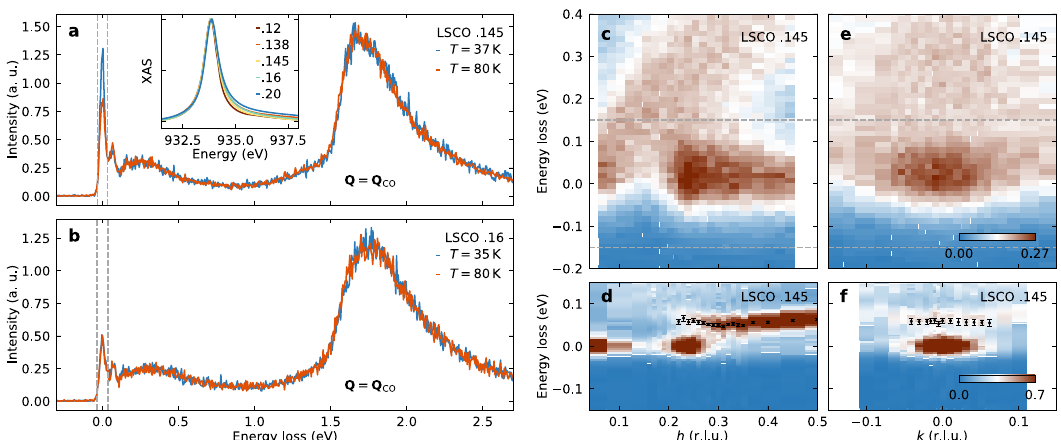
Fig. 1 X-ray absorption and resonant inelastic x-ray scattering spectra recorded on La 2 − x Sr x CuO 4 as a function of energy loss and momentum. a , b High-resolution RIXS spectra recorded on LSCO x = 0.145 and 0.16 at the charge ordering vector for different temperatures as indicated. Vertical dashed lines indicate the energy resolution and with that the integration window of elastic scattering. The intensity is given in arbitrary units (a. u.). The inset shows XAS spectra featuring the copper L -edge for LSCO with doping concentrations as indicated. c – f RIXS spectra probed in longitudinal ( h ) and transverse ( k ) directions on LSCO x = 0.145. Data in c , e are recorded with an energy resolution of 129 meV, whereas d , f show spectra recorded at a high-resolution beamline with a total resolution of 33 meV. Horizontal dashed lines in c , e illustrate the energy range in d , f . The improved resolution allows for resolving the phonon branch. The black circles mark the phonon dispersion determined from fi tting the spectra. Error bars are set by standard deviation from fi tting. High-resolution data were taken at 37 K, all other data at base temperature, see the “ Methods ” independent for x = 0.16. The momentum dependence of elastic and inelastic scattering recorded on LSCO x = 0.145 is shown in Fig. 1c – f for longitudinal ( h ) and projected transverse ( k ) directions. In Fig. 1c, e data are recorded with an overall energy resolution of 129 meV (FWHM), whereas in d, f the resolution is 33 meV. The direct comparison illustrates how the quasielastic scattering in c and e includes both elastic and phonon responses. Since the intensity from the charge order peak and the phonon branch are comparable, differentiation can only be reached by applying suf fi ciently high energy resolution. Lack of suf fi cient energy resolution implies a convolution of charge order and phonon scattering intensities. The optical phonon branch, extracted from the high-resolution data of LSCO x = 0.145 in Fig.